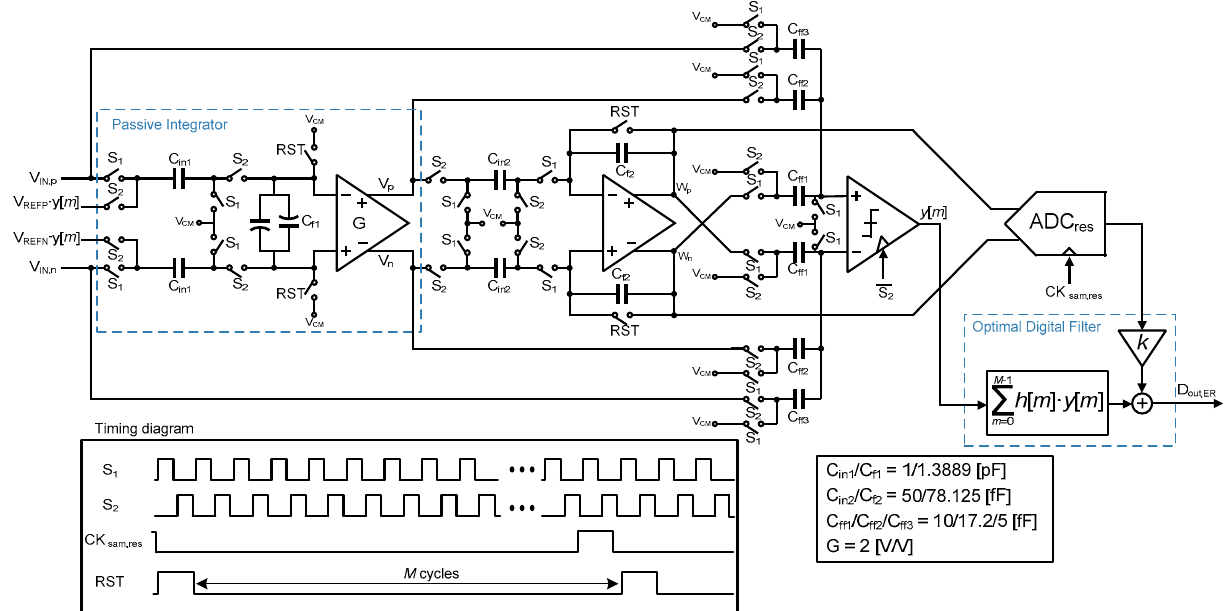
Figure 9. Overall IDSM architecture using a leaky integrator for the 1st stage and optimal digital filter. Table 3. ADC parameters for behavioral simulations.